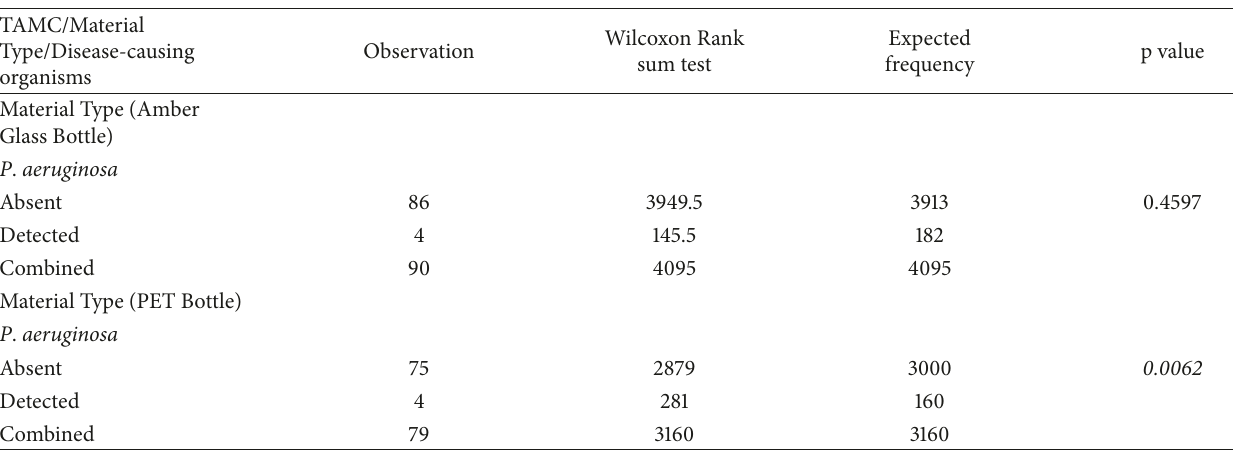
Table 4: Relationship between the levels of contamination (TAMC) and presence of P . aeruginosa in the products packaged in amber glass bottles and PET